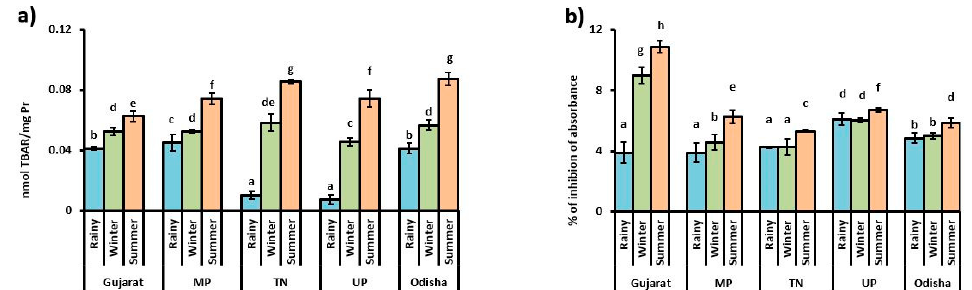
Figure 1. Seasonal variation of oxidative stress and total antioxidant activity of P. globosa . The oxidative stress condition was determined by assay of the lipid peroxidation level ( a ) in the snails while the total antioxidant capacity in the form of DPPH scavenging activity ( b ) was measured by DPPH scavenging activity. The data represent mean ± SEM with superscripts indicating statistical differences between mean values at p < 0.05 level.